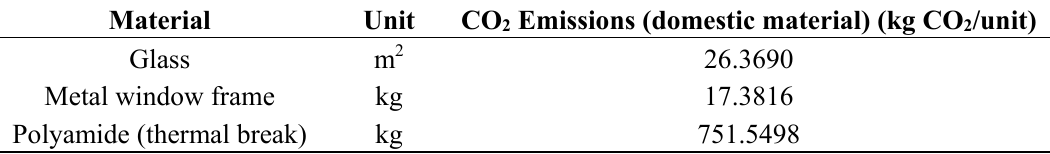
Table 11. Embodied CO 2 emissions factor.